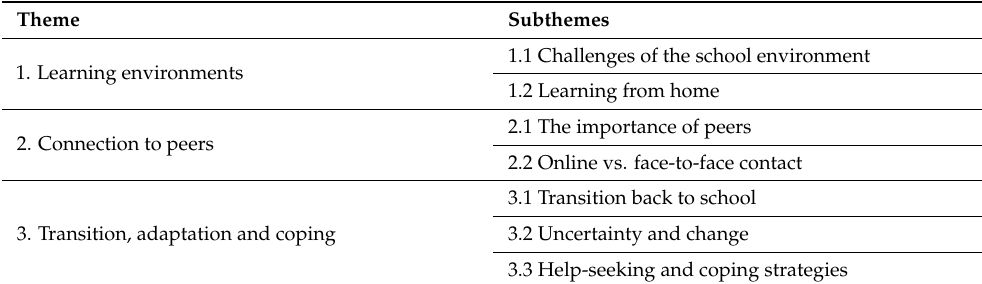
Table 2. Overview of themes and